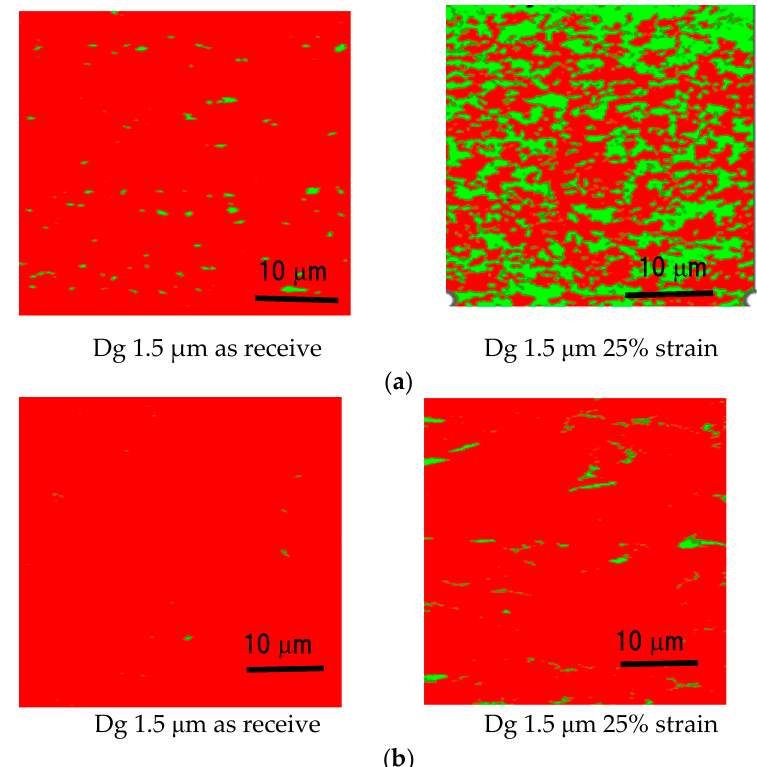
Figure 1. The phase map of SUS 304 fine grain and coarse grain [20]. ( a ) Fine grain; ( b ) Coarse grain.